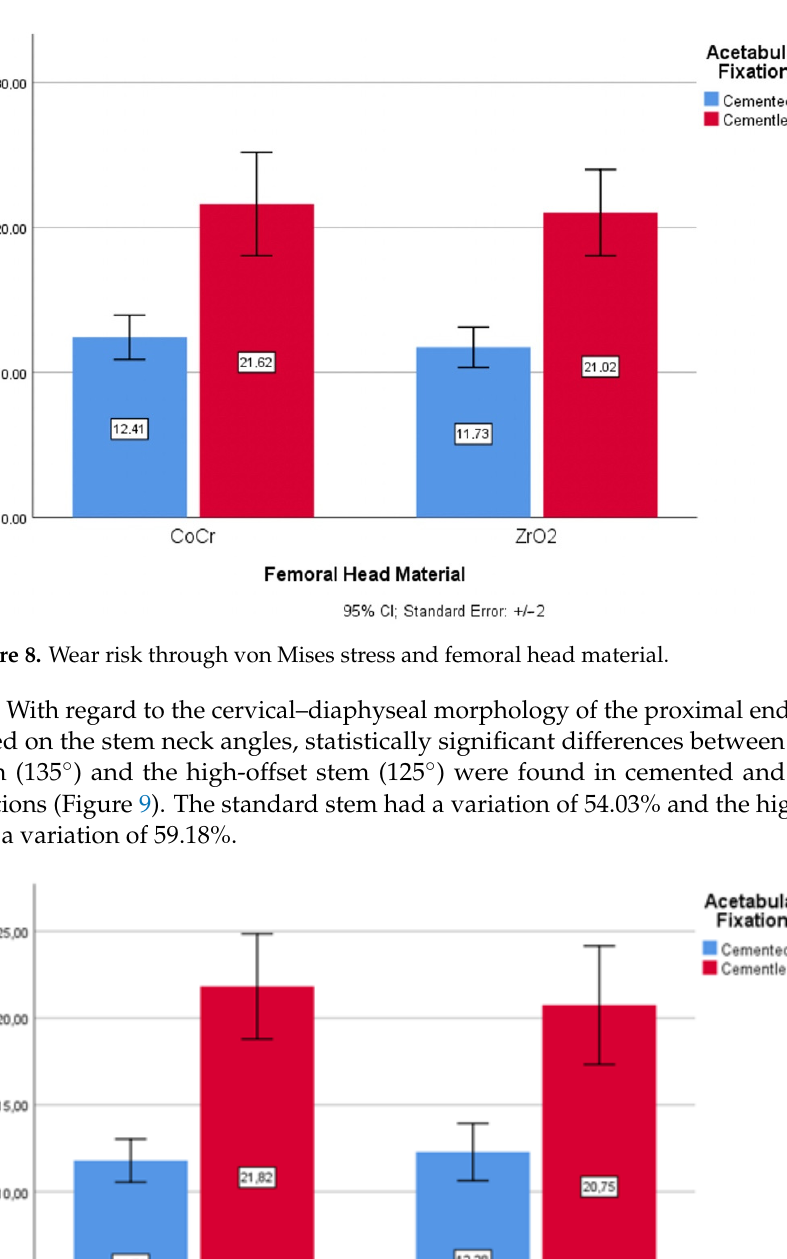
Figure 9. Wear risk through von Mises stress and stem neck angles.